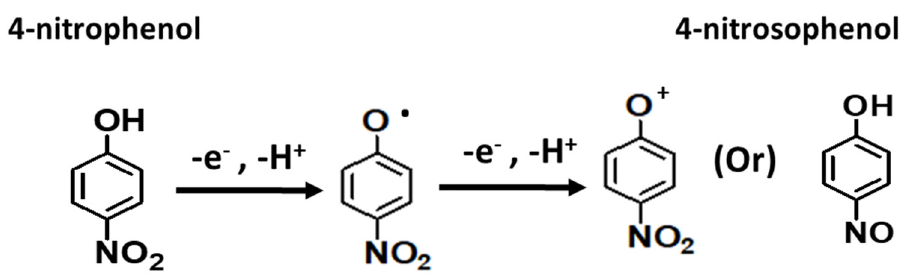
Figure 11. ( a ) Stability responses of Ag-ZnO/GCE ( b ) Ag-ZnO/GCE electrode response current in 500 µM 4-NP containing 0.1 M PBS (pH = 7) solution. (Accumulation time: 2 min, catalyst loading volume: 10 µL). In addition, the interference study was analyzed to understand the selectivity of the Ag-ZnO/GCE electrode with 4-NP containing inorganic/organic interference chemicals as shown in Figure 12. From Figure 12, it can be seen that the noticeable change in the 4-NP oxidation peak current, which confirmed the poor selectivity of the Ag-ZnO/GCE elec- trode towards 4-NP with interference chemicals; however, the Ag-ZnO/GCE electrode showed high sensitivity towards 4-NP in the neutral medium. In addition, the sensitivity of Ag-ZnO/GCE electrode was compared to previously reported sensor electrodes in Ta- ble 1